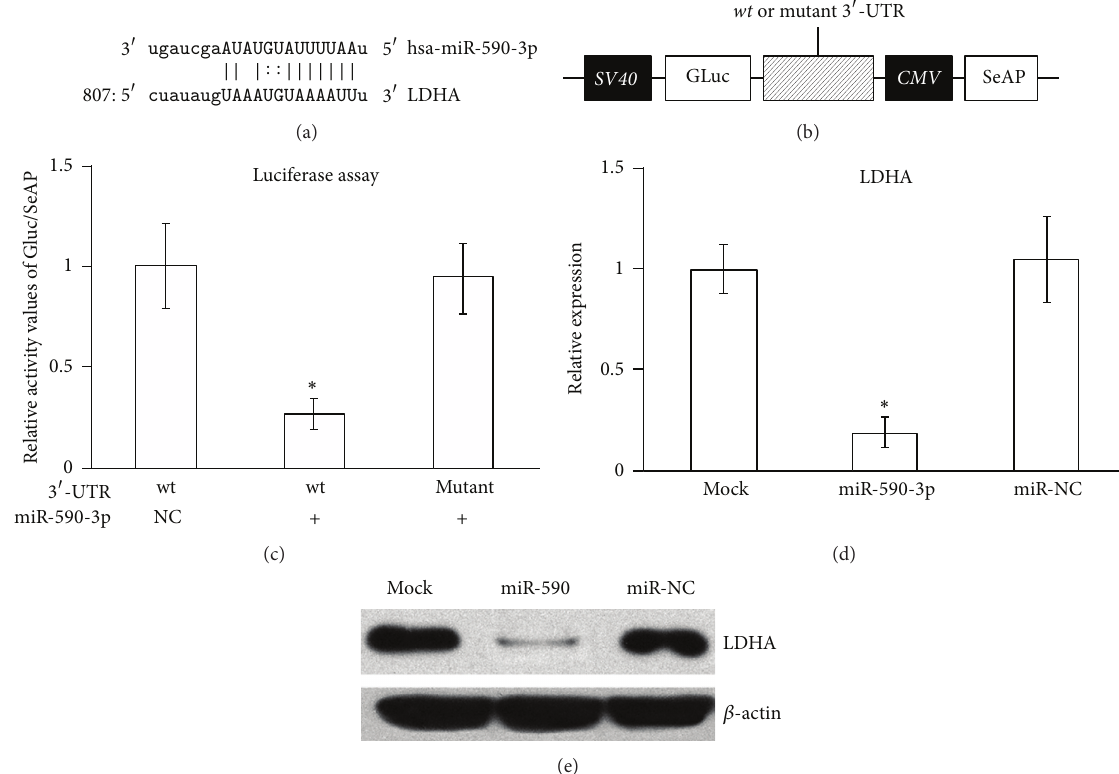
Figure 1: Sequence alignment of hsa-miR-590-3p and LDHA mRNA and confirmation of inhibitory function of hsa-miR-590-3p on LDHA using luciferase assay and HeLa cells. (a) Sequence alignment of hsa-miR-590-3p and LDHA mRNA. (b) The construct for luciferase assay. (c) The relative activity of GLuc/SeAP in luciferase assay. (d) Real-time qPCR results of LDHA expression in HeLa cells transfected with no miR, miR-590, and miR-NC. (e) Western blot results for LHDA protein in HeLa cells transfected with no miR, miR-590, and miR-NC. All values are given as mean; error bar represents standard error. ∗ 𝑝 < 0.05